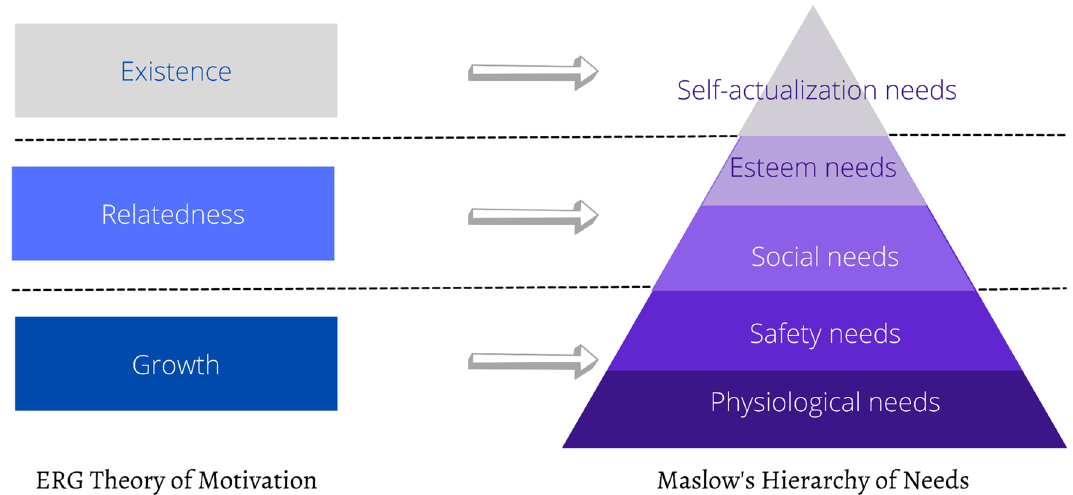
Fig. 1 ERG Theory of Motivation and Maslow’s Hierarchy of Needs (McLeod, 2007; Alderfer, 1969)